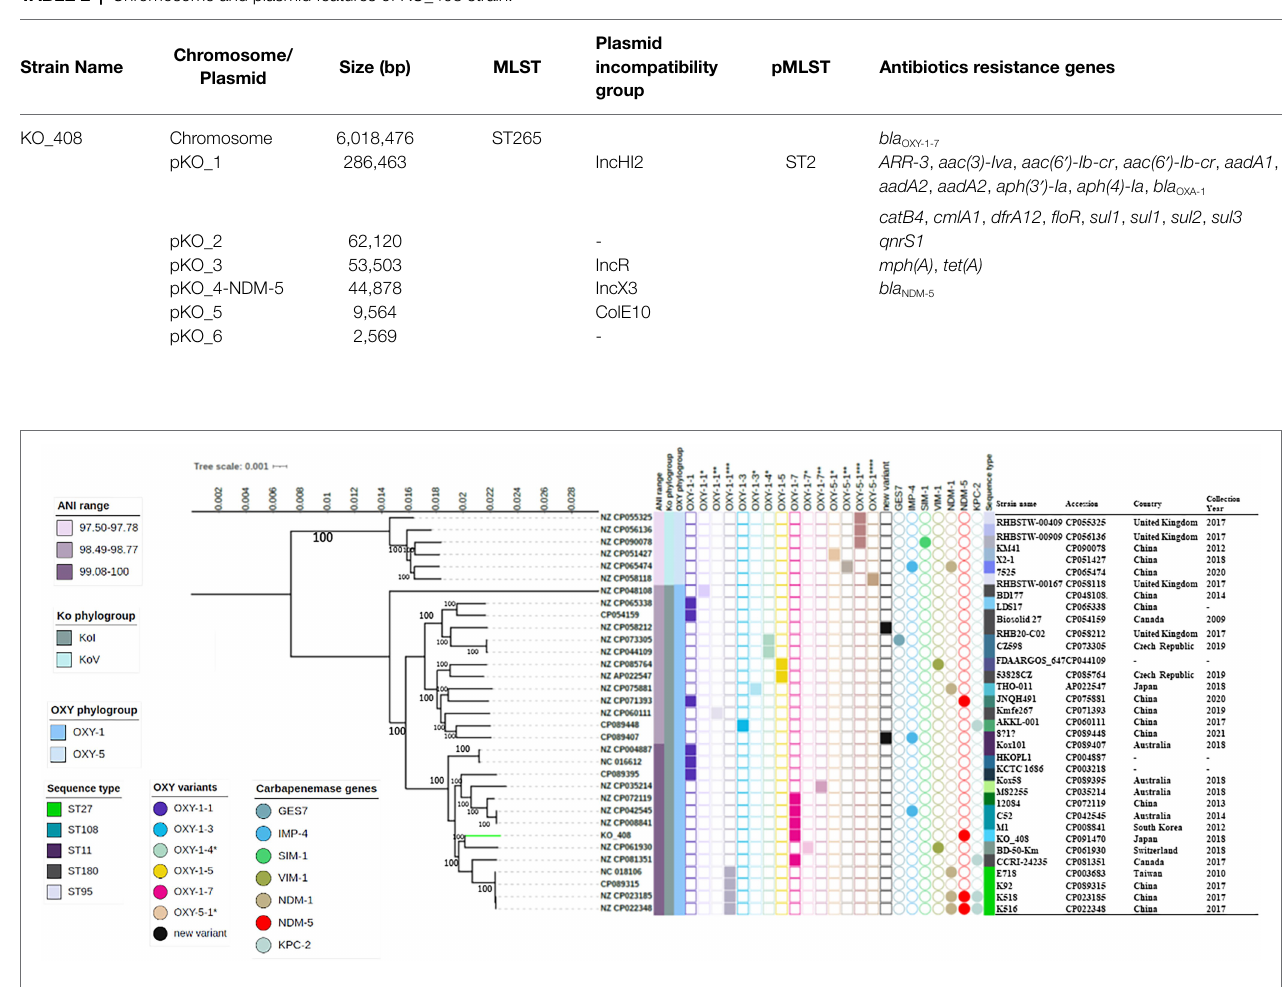
FIGURE 1 | Maximum-likelihood phylogenetic tree based on Klebsiella michiganensis core-genomes. The tree was rooted on the node of KoV. Bootstrap values are shown next to major nodes. Strain labels are given as the strain GenBank ID, except that of KO_408. The phylogeny of KO_408 with respect to the other K. michiganensis genomes is highlighted with a green branch color. The major phylogroups and the OXY variants in these genomes are indicated along with their sequence types. OXY variants with an identity <99% to Resfinder references are represented on the tree as new variants, whereas those with an identity >99% but not 100% identity to the reference are shown by the query result with the * numbers representing their similarity to the reference. Sequency types (STs) with two or more frequencies are shown in the figure legend and the remaining STs are described in Supplemental_data_file1 . The occurrence of carbapenemase genes in these genomes is also illustrated, as well as the genome